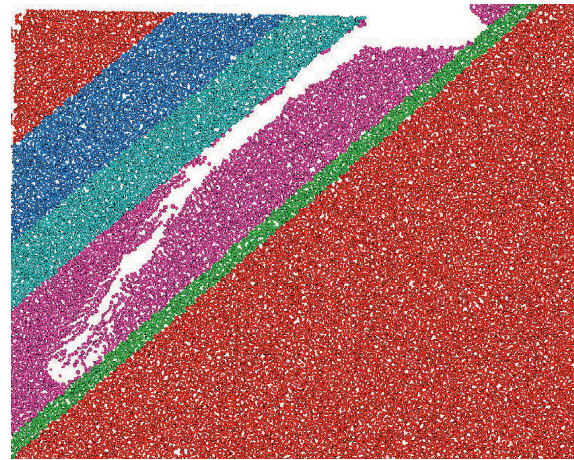
Figure 9: Single-sequence coal caving.